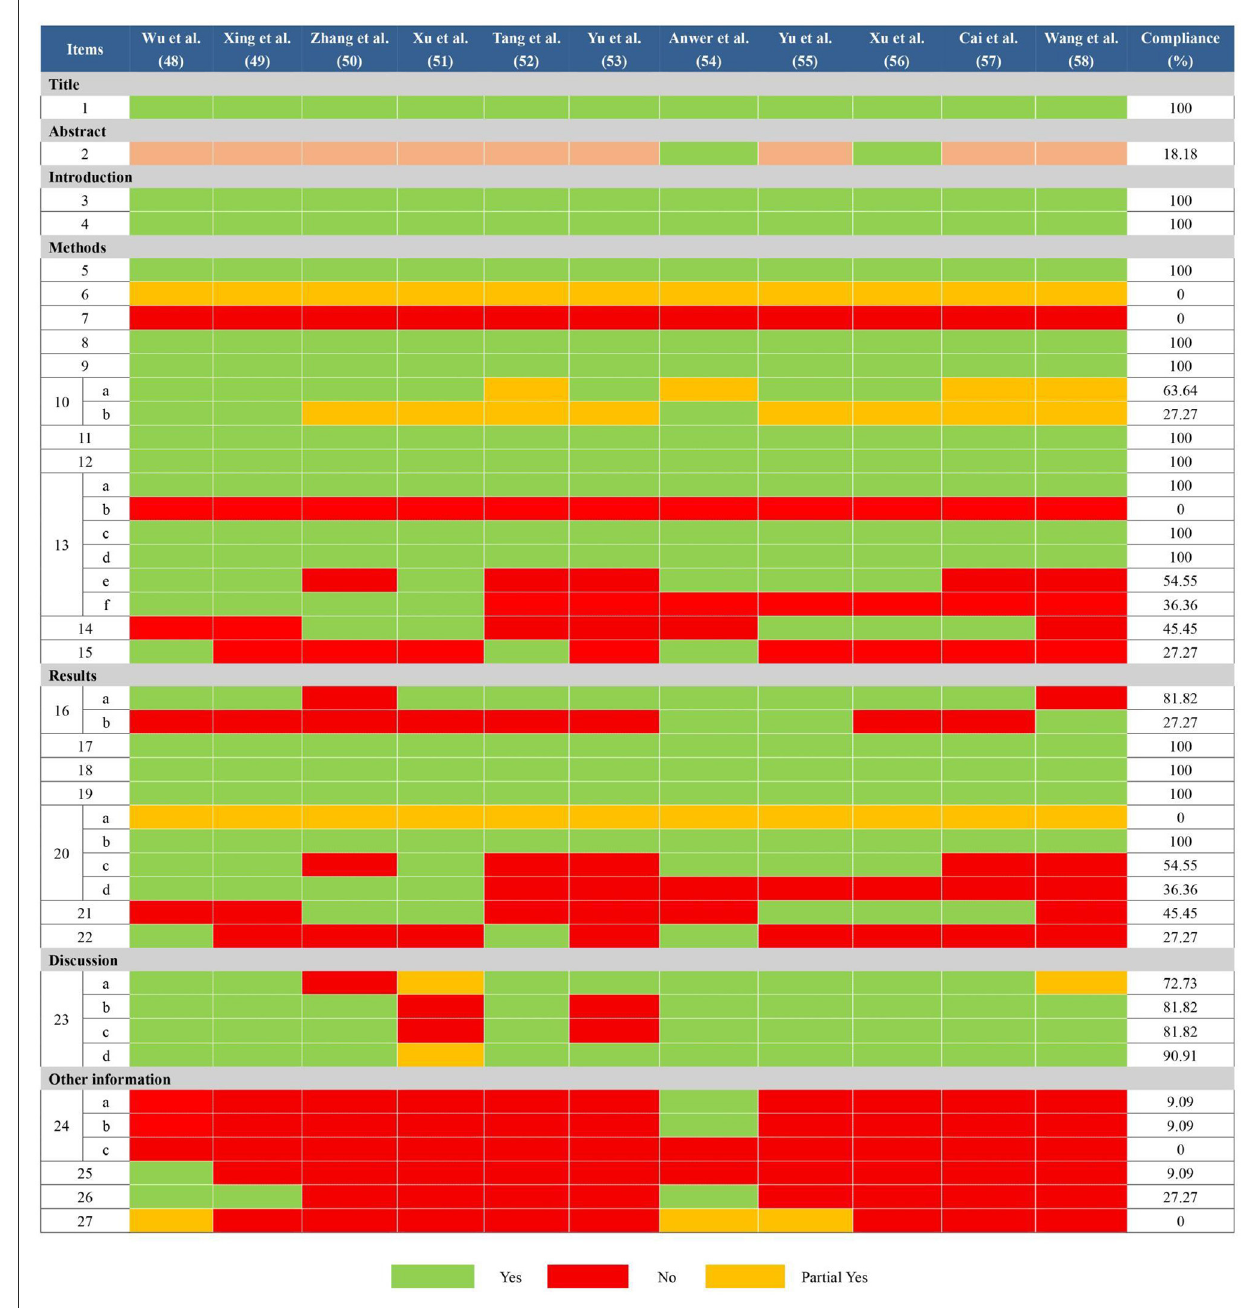
FIGURE3 Results of the PRISMA 2020 assessments. Item 1: Title; Item 2: Abstract; Item 3: Rationale; Item 4: Objectives; Item 5: Eligibility criteria; Item 6: Information sources; Item 7: Search strategy; Item 8: Selection process; Item 9: Data collection process; Item 10: Data items; Item 11: Study risk